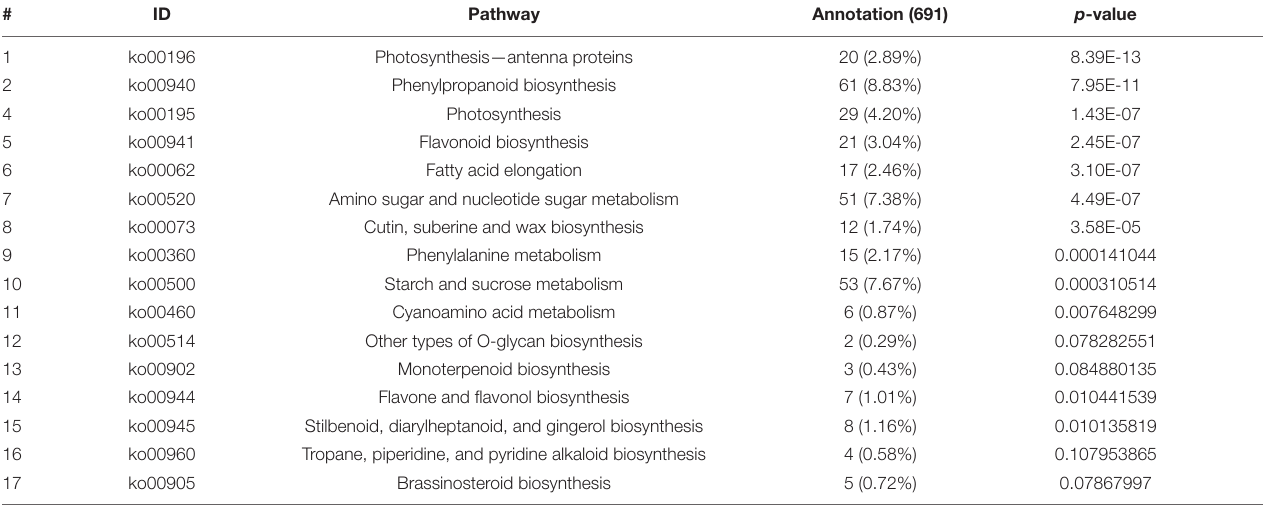
TABLE 3 | KEGG pathways of